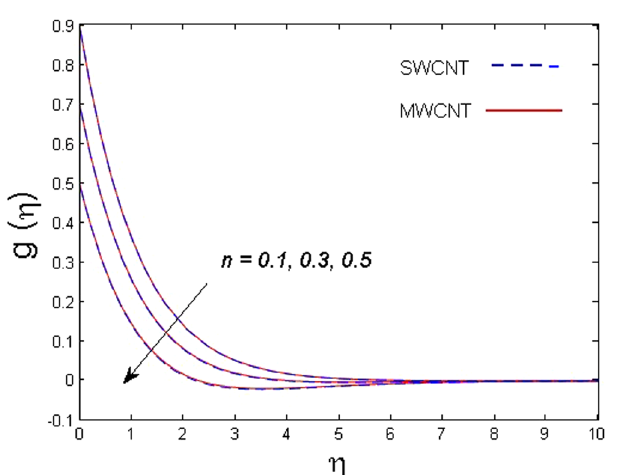
Figure 10. Outcome of S c on η g ( ) .